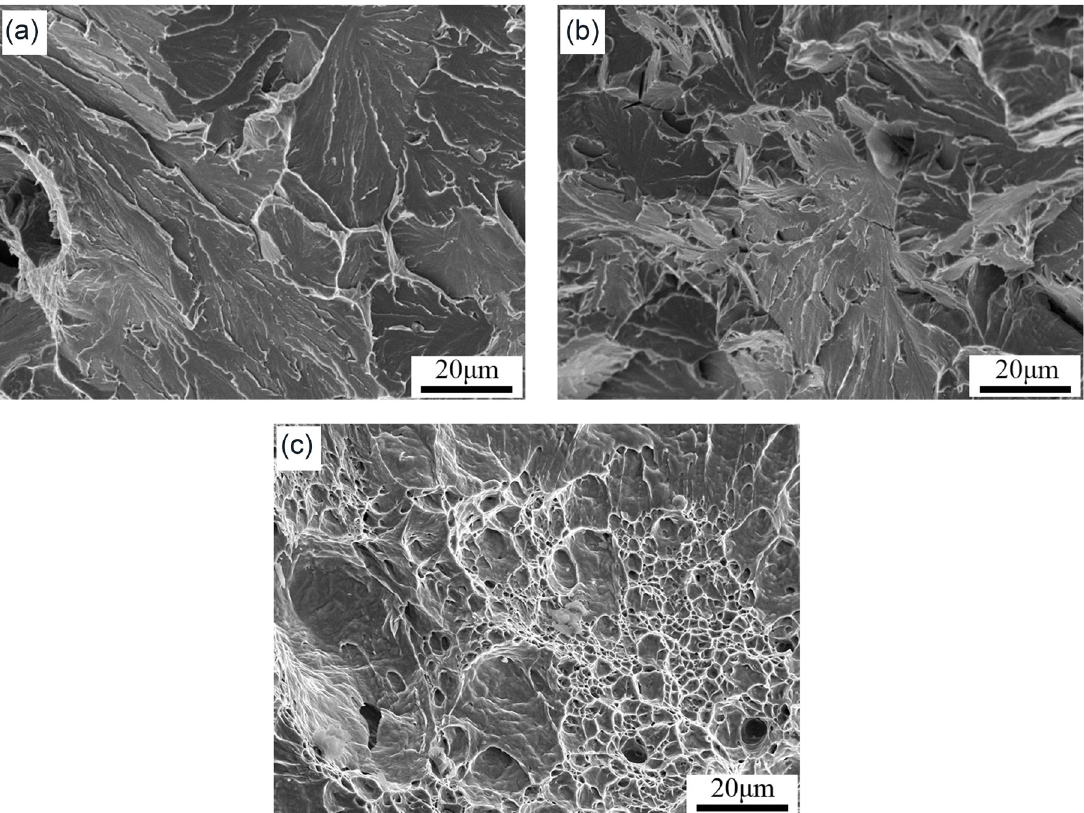
Figure 5. Impact fracture morphology of CGHAZ steel under different the welding heat input: (a) 18kJ·cm -1 , (b) 24kJ·cm -1 and (c) 30kJ·cm -1 .